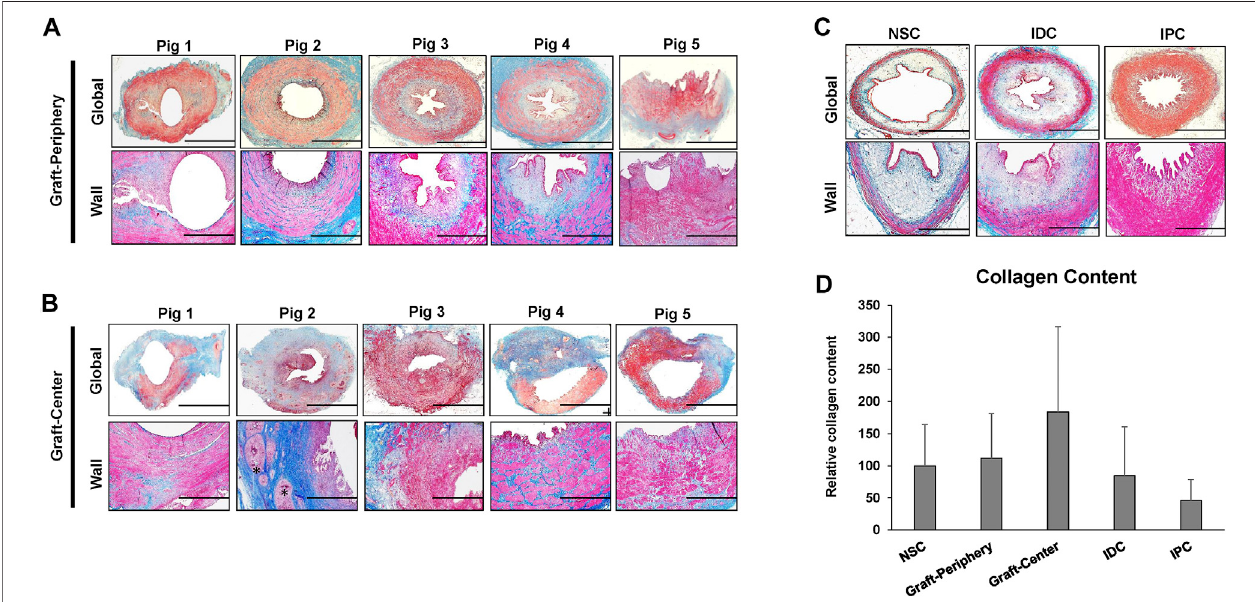
FIGURE4|Histologicalassessmentsofureteraltissuearchitectureincontrolsandneotissues. Photomicrographsofperipheral (A) andcentral (B) areas of reconstructed tissues from all swine as well as control groups consisting of NSC, IPC, and IDC segments procured from Pig 5 (C) stained with Masson ’ s trichrome. Gross cross-sections of ureteral tissues are presented in top rows with magni fi ed views of the ureteral wall displayed in the second row of panels. Scale bars for 1 st and 2 nd rows in each panel are 1 cm and 400 μ m, respectively. A semi-circumferential ureteral section is displayed for the graft-periphery of Pig 5. Asterisk denotes residual scaffold fragments in A-B. (D) Quantitation of collagen content in MTS-stained specimens displayed in (A – C) . For all panels, N (cid:1) 5 animals per group were assessed per data point. For panel D, data were analyzed with Kruskal – Wallis test. p (cid:1) 0.326. Values are displayed as means ± SD. NSC, nonsurgical controls; IPC, internal proximal controls; IDC, internal distal